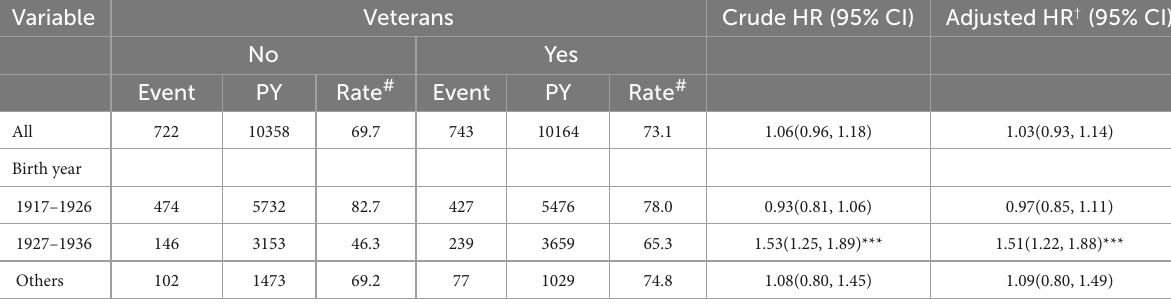
TABLE 5 Comparison of incidence and hazard ratio of all-cause mortality and stratified by birth year. Variable